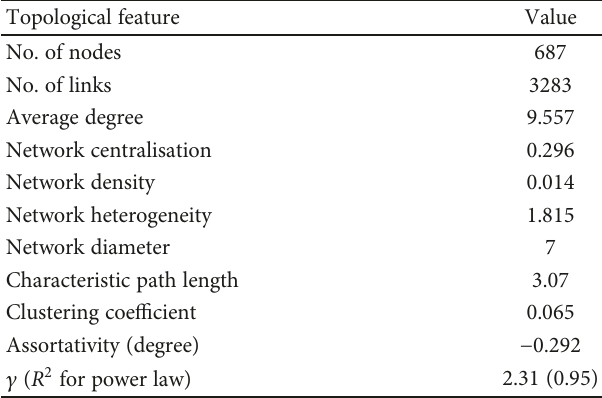
Figure 1: Visualisation of (1) the UCR-SCN (left), and (2) the tiered DMF-SCN in reference 6 (right). The shade of green is set proportional to the node Table 2: Basic topological features of the undirected contractual relationship SCN.